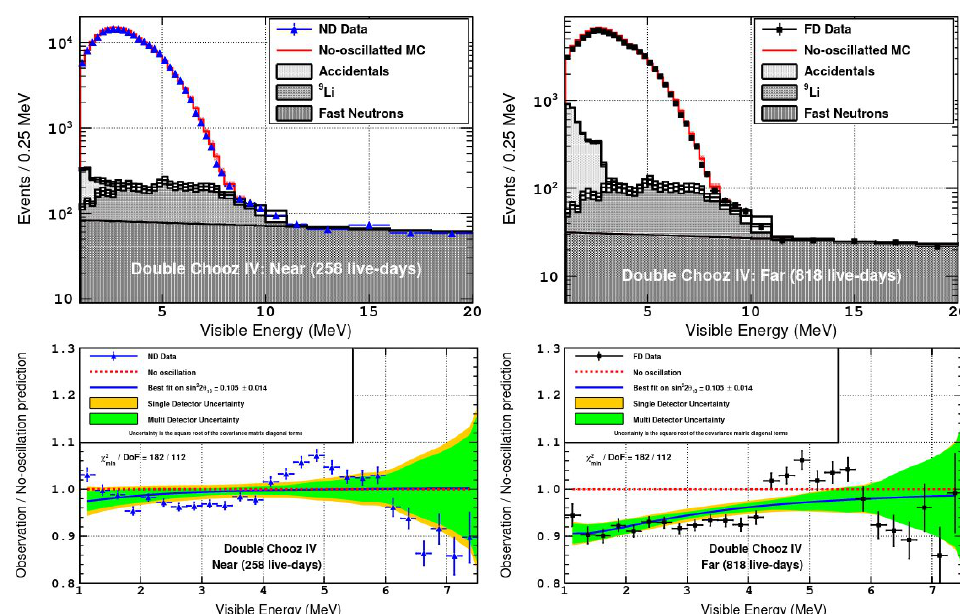
Figure 3. ND ( left ) and FD ( right ) spectra and single-detector ratios. Both ND and FD spectra are shown in the top plots, including the un-oscillated MC prediction (red) and the background model: accidentals (clear grey), 9 Li (grey) and fast-neutron (dark grey). The data (background subtracted) to prediction ratio is shown in the bottom panels [14].